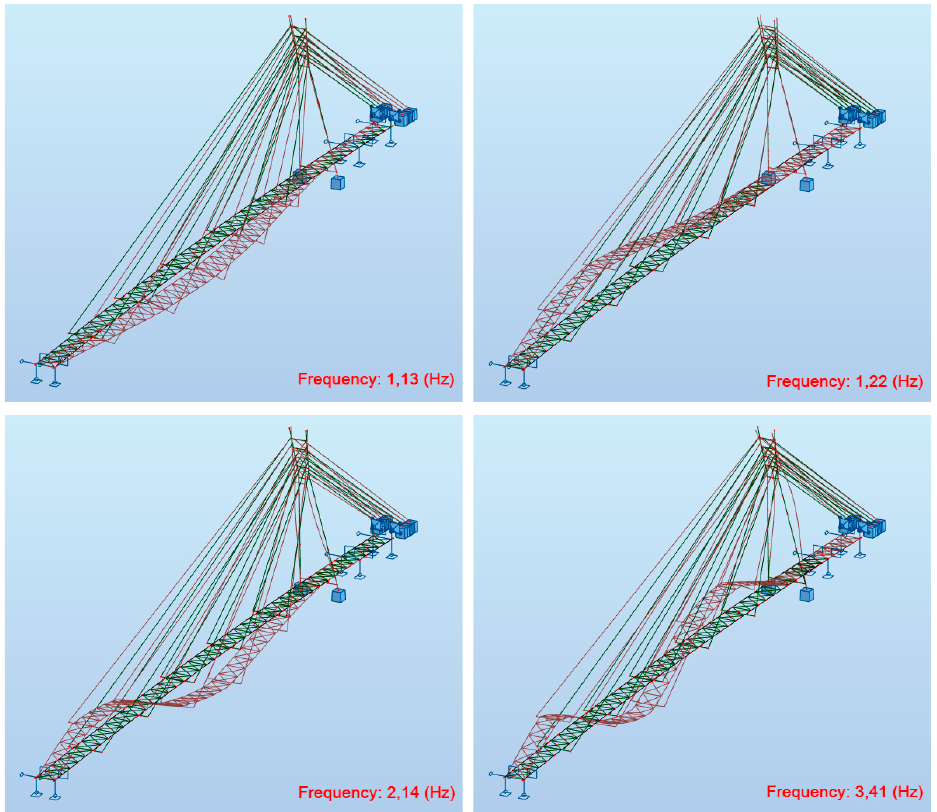
Figure 14. Results of dynamic calculations conducted on the updated model.